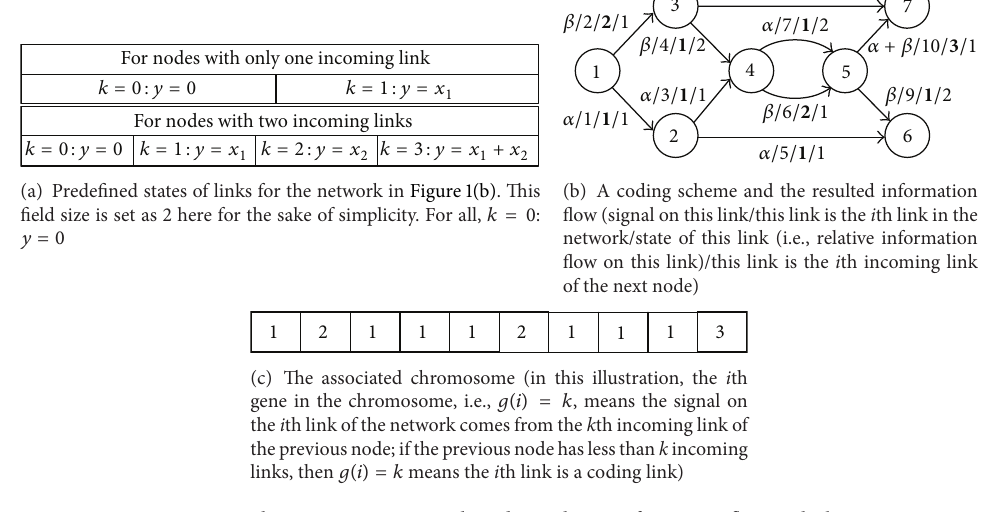
Figure 11: Chromosome structure based on relative information flow on links.